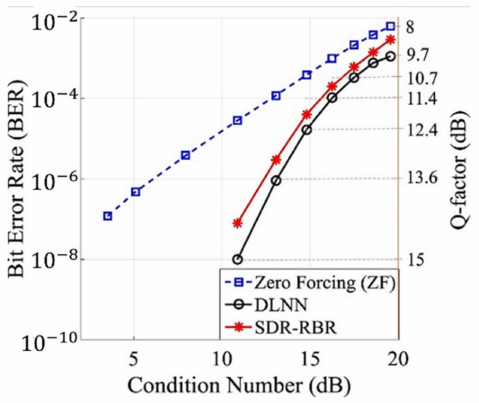
Figure 24. The BER performance of DLNN, ZF and SDR-RBR.